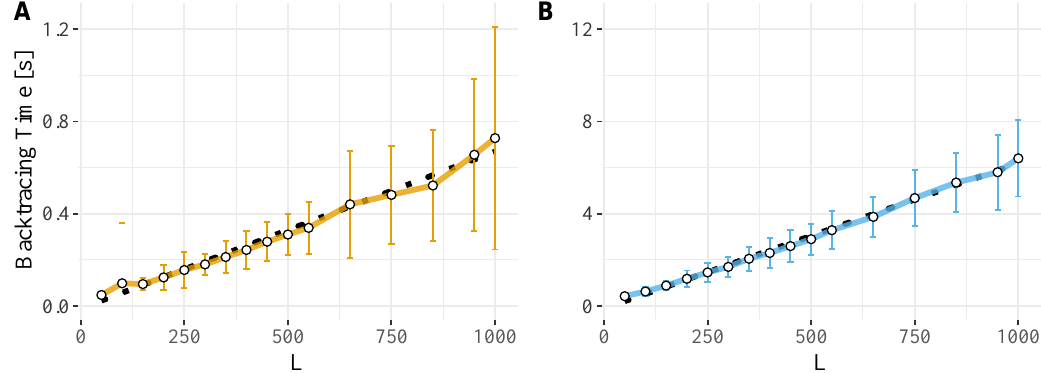
Figure 1. CPU requirements for backtracking the MFE structure in RNALfold. The performance of the implementation ViennaRNA conforms to a linear dependence of backtracking time per nucleotide with base pair span L , i.e., t CPU ∼ ∑ nL . Shown is the computational overhead for different window sizes L that were obtained from averaging over 100 random sequences of length ( A ) 10,000 nt and ( B ) 100,000 nt. Error bars denote the standard deviation within the sets of 100 runs, and a linear fit is depicted by a dashed black